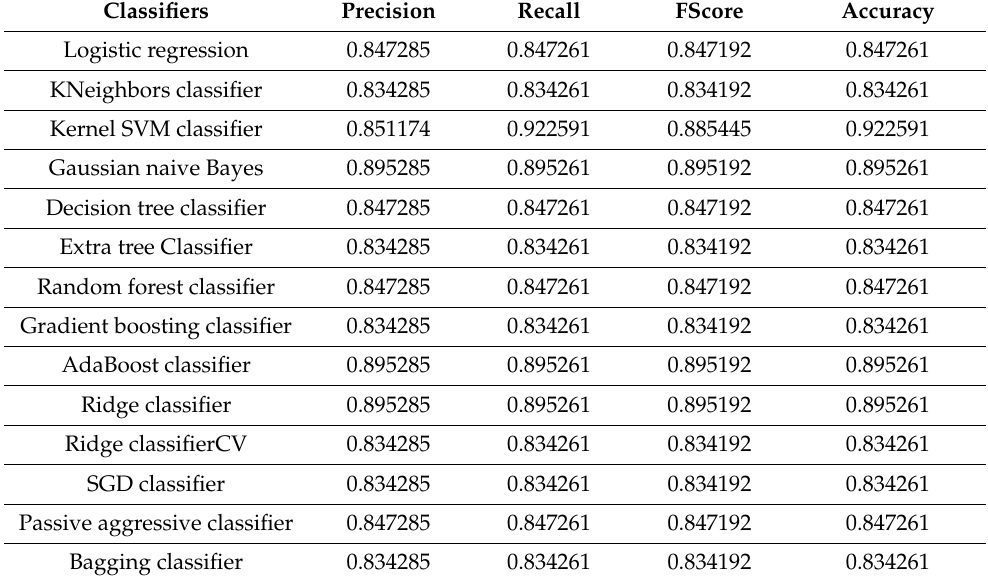
Table 15. Random forest regressor metrics before feature